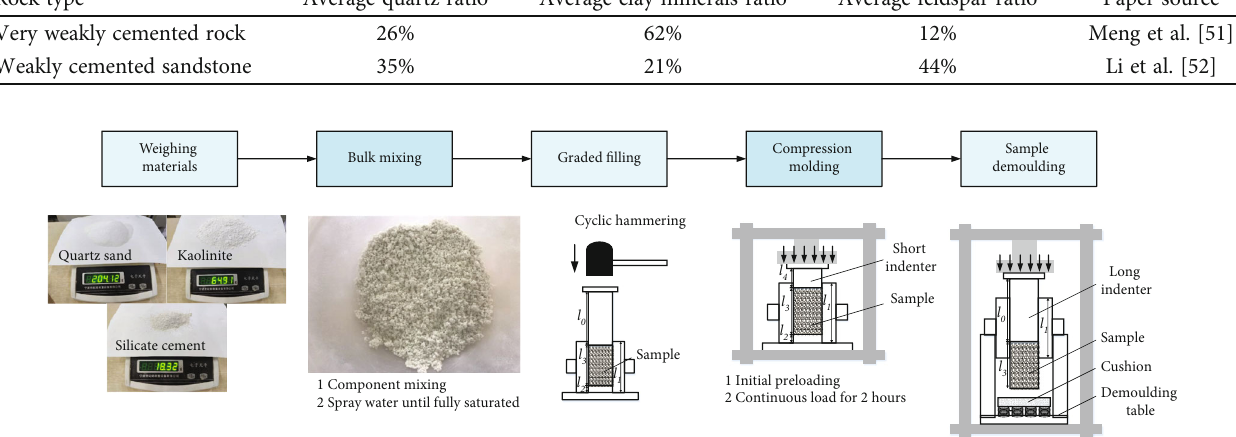
Figure 1: Preparation fl ow chart of weakly cemented rock sample.